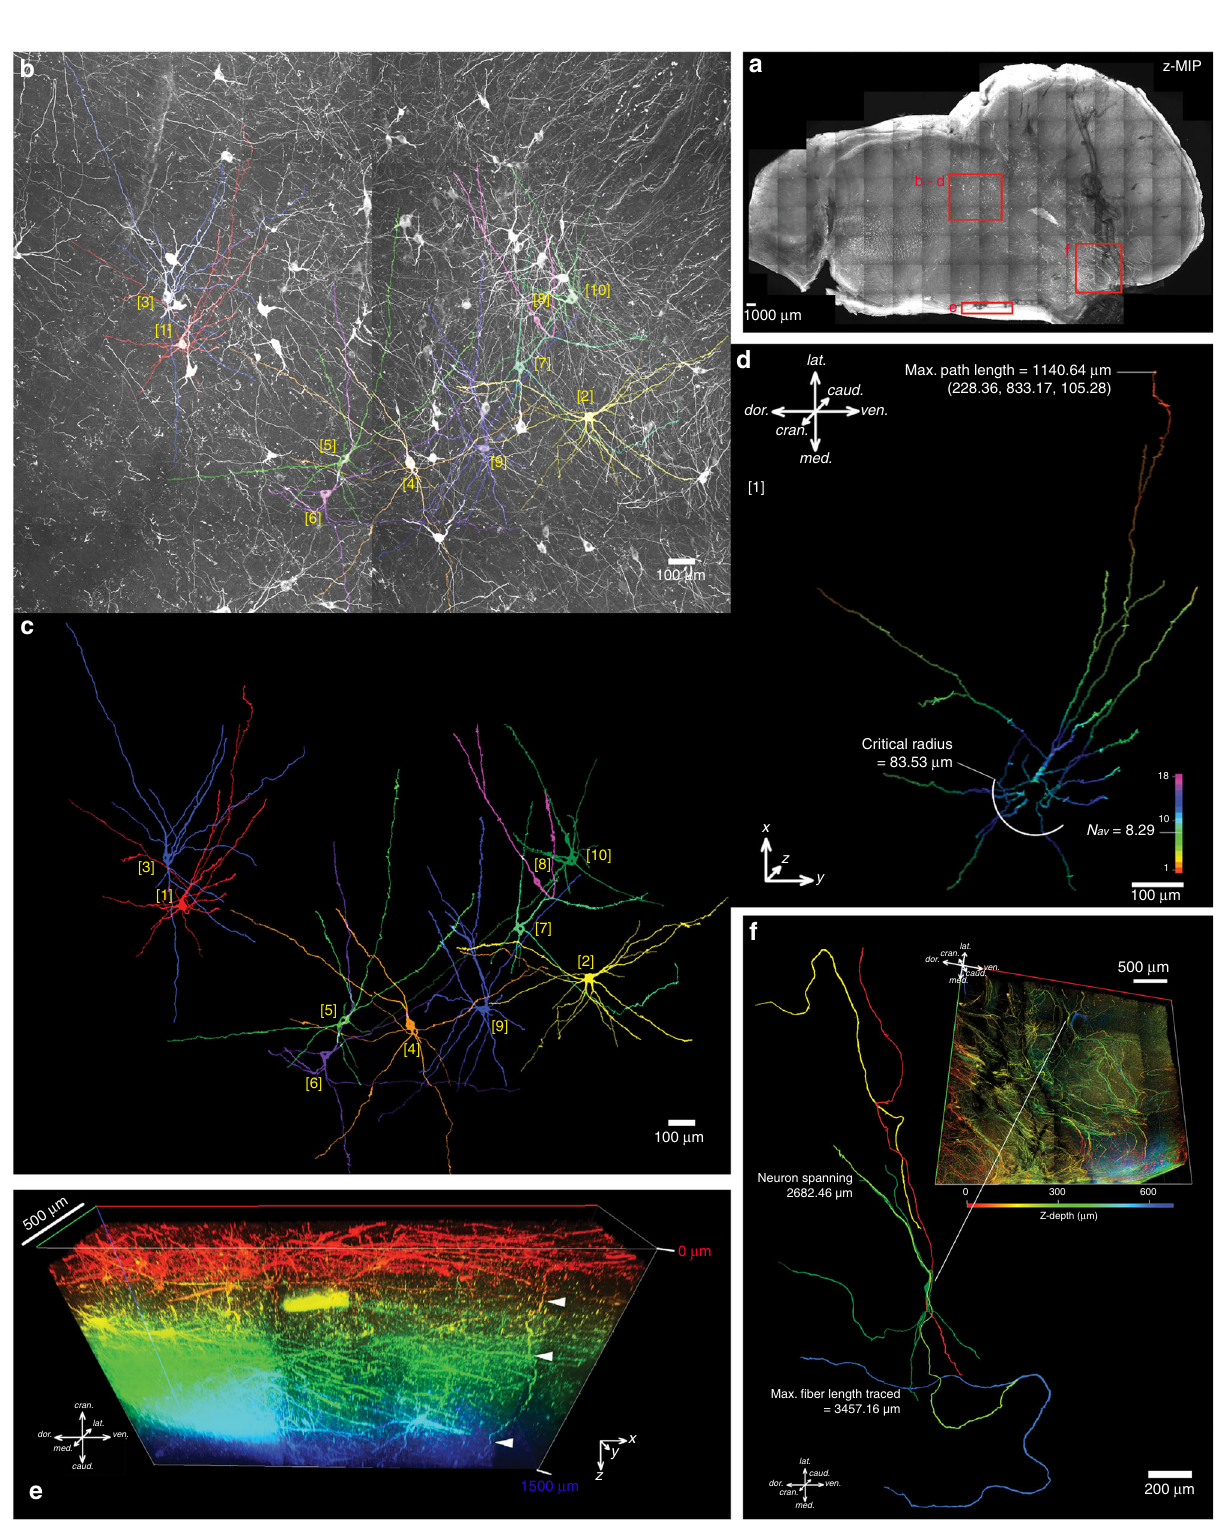
of delipidation with cresyl violet staining for samples fi xed for 3 weeks (Fig. 5). Finally, an imaging depth of 1500 µm was achieved with 3.5 months of delipidation for samples fi xed for 1 week with immuno fl uorescence (Fig. 4). In a recent study using a modi fi ed CLARITY protocol (hydrogel embedding with 2% acrylamide/0.05% bisacrylamide), human brain samples were cleared and imaged down to 5 mm in depth with both active